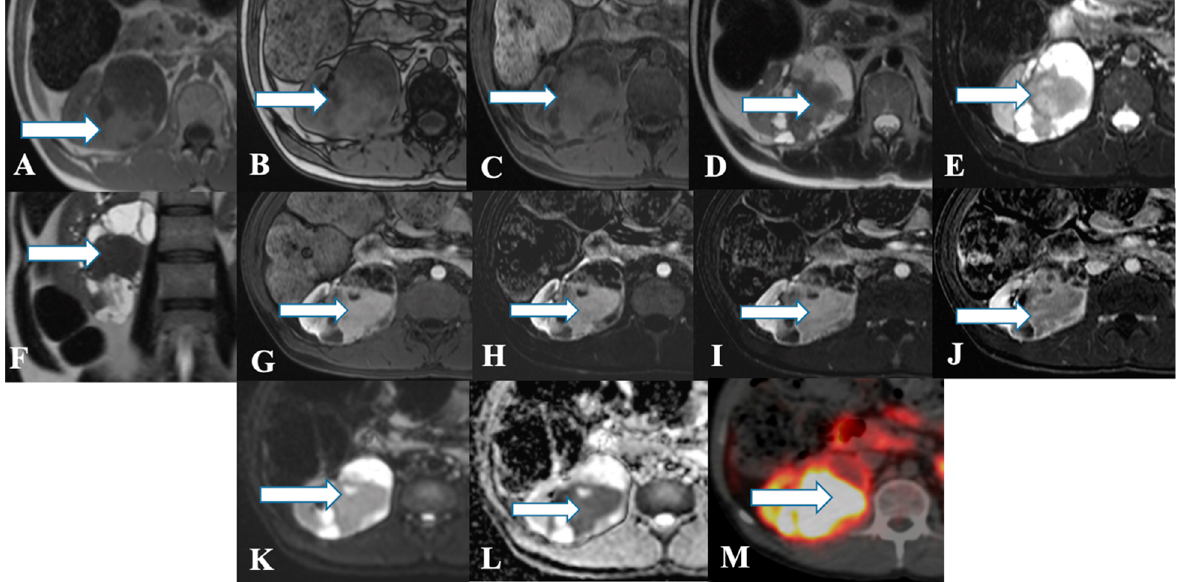
Figure 4. A 45-year-old female with renal NEN. MRI axial T1 ( A ) in phase, ( B ) out of phase, ( C ) 3D axial, ( D ) T2, ( E ) T2 fat saturation, ( F ) coronal T2, ( G ) post-contrast dynamic, ( H , I ) dynamic subtraction images, ( J ) delayed postcontrast axial, ( K ) DWI, and ( L ) ADC show a large right renal mid and lower pole mass (arrows) measuring 6.6 × 7.1 cm showing central enhancing solid component with restricted diffusion and peripheral cystic component. Pathology revealed a neuroendocrine tumor. ( M ) Axial fused PET/CT images using Gallium 68 Dotatate show heterogeneously avid DOTATATE uptake of the mass (arrow), in keeping with biopsy-confirmed right kidney neuroendocrine carcinoma.